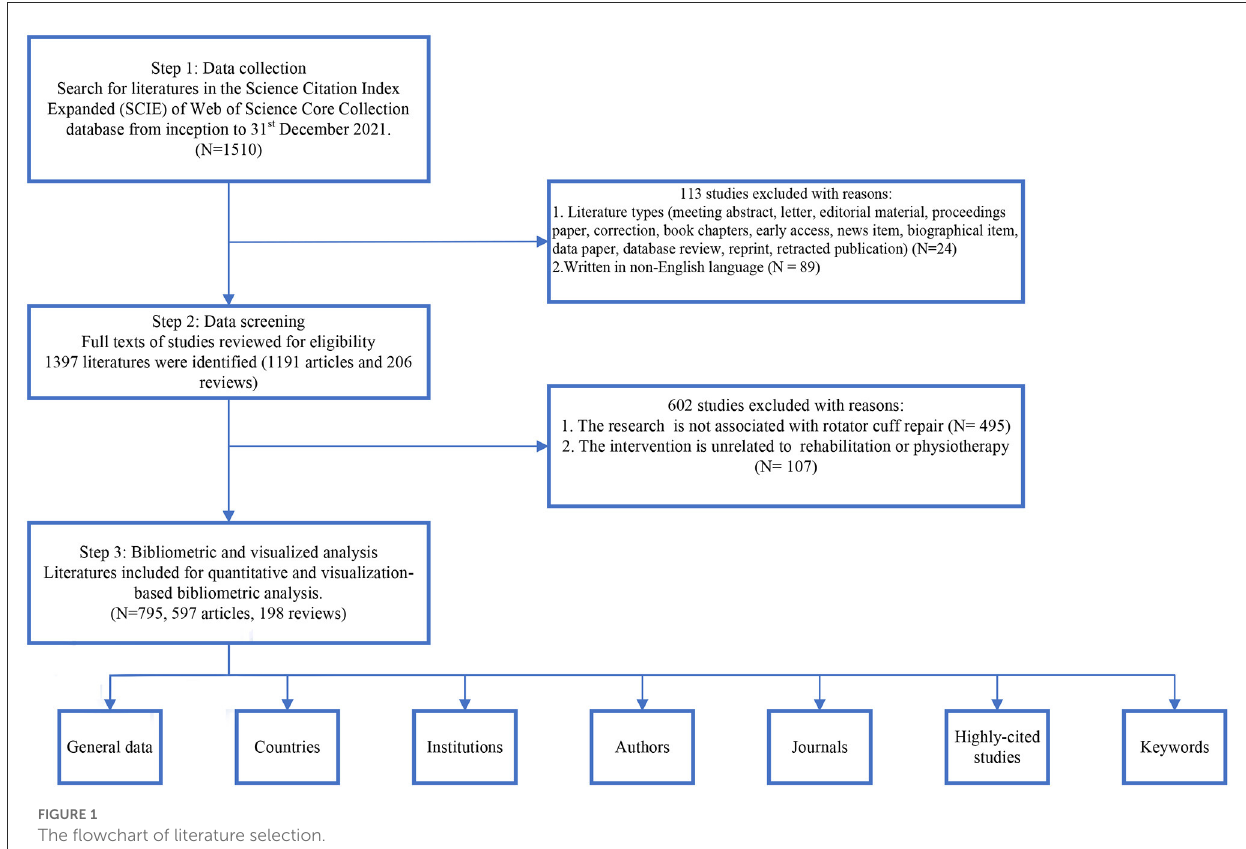
FIGURE1 The flowchart of literature selection.